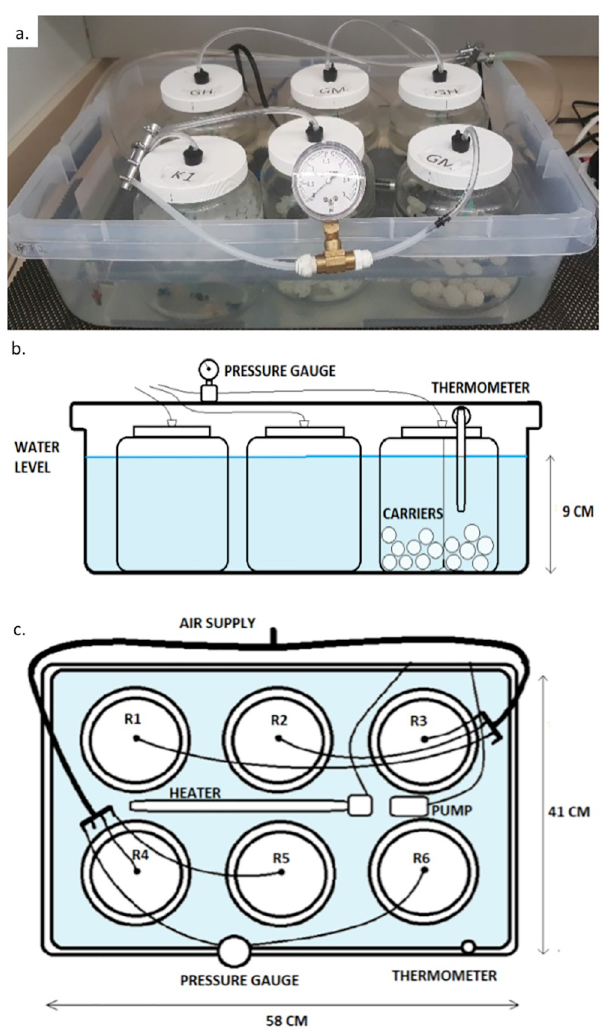
Fig 2. Bench-scale MBBSBRs used for experimentation; (a) photograph of one system containing 6 reactors; (b) side-view schematic; (c) top-view